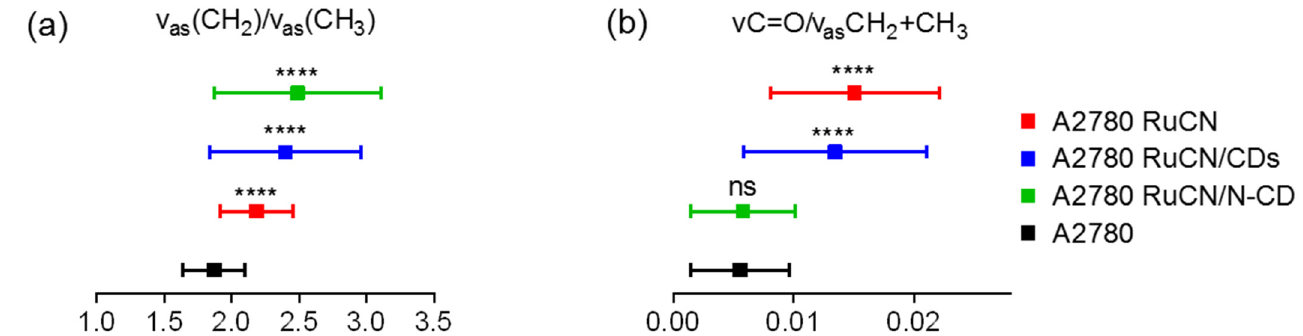
Figure 5. Analysis of oxidative stress markers. ( a ) Distribution of the ratios between asymmetric CH 2 and CH 3 bands ( ν as (CH 2 )/ ν as (CH 3 )). ( b ) Distribution of the ratio between the C=O band and the sum of asymmetric CH 3 and CH 2 bands ( ν (C=O)/ ν as (CH 2 + CH 3 )). Values are presented with the mean ± SD. All the values are compared to the control (A2780 untreated cells, black color). **** indicates values that are significantly different ( p ≤ 0.0001); ns, not significant ( p > 0.05).